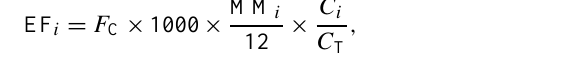
ing CH 4 as a reference gas for N 2 O emissions ( R 2 =